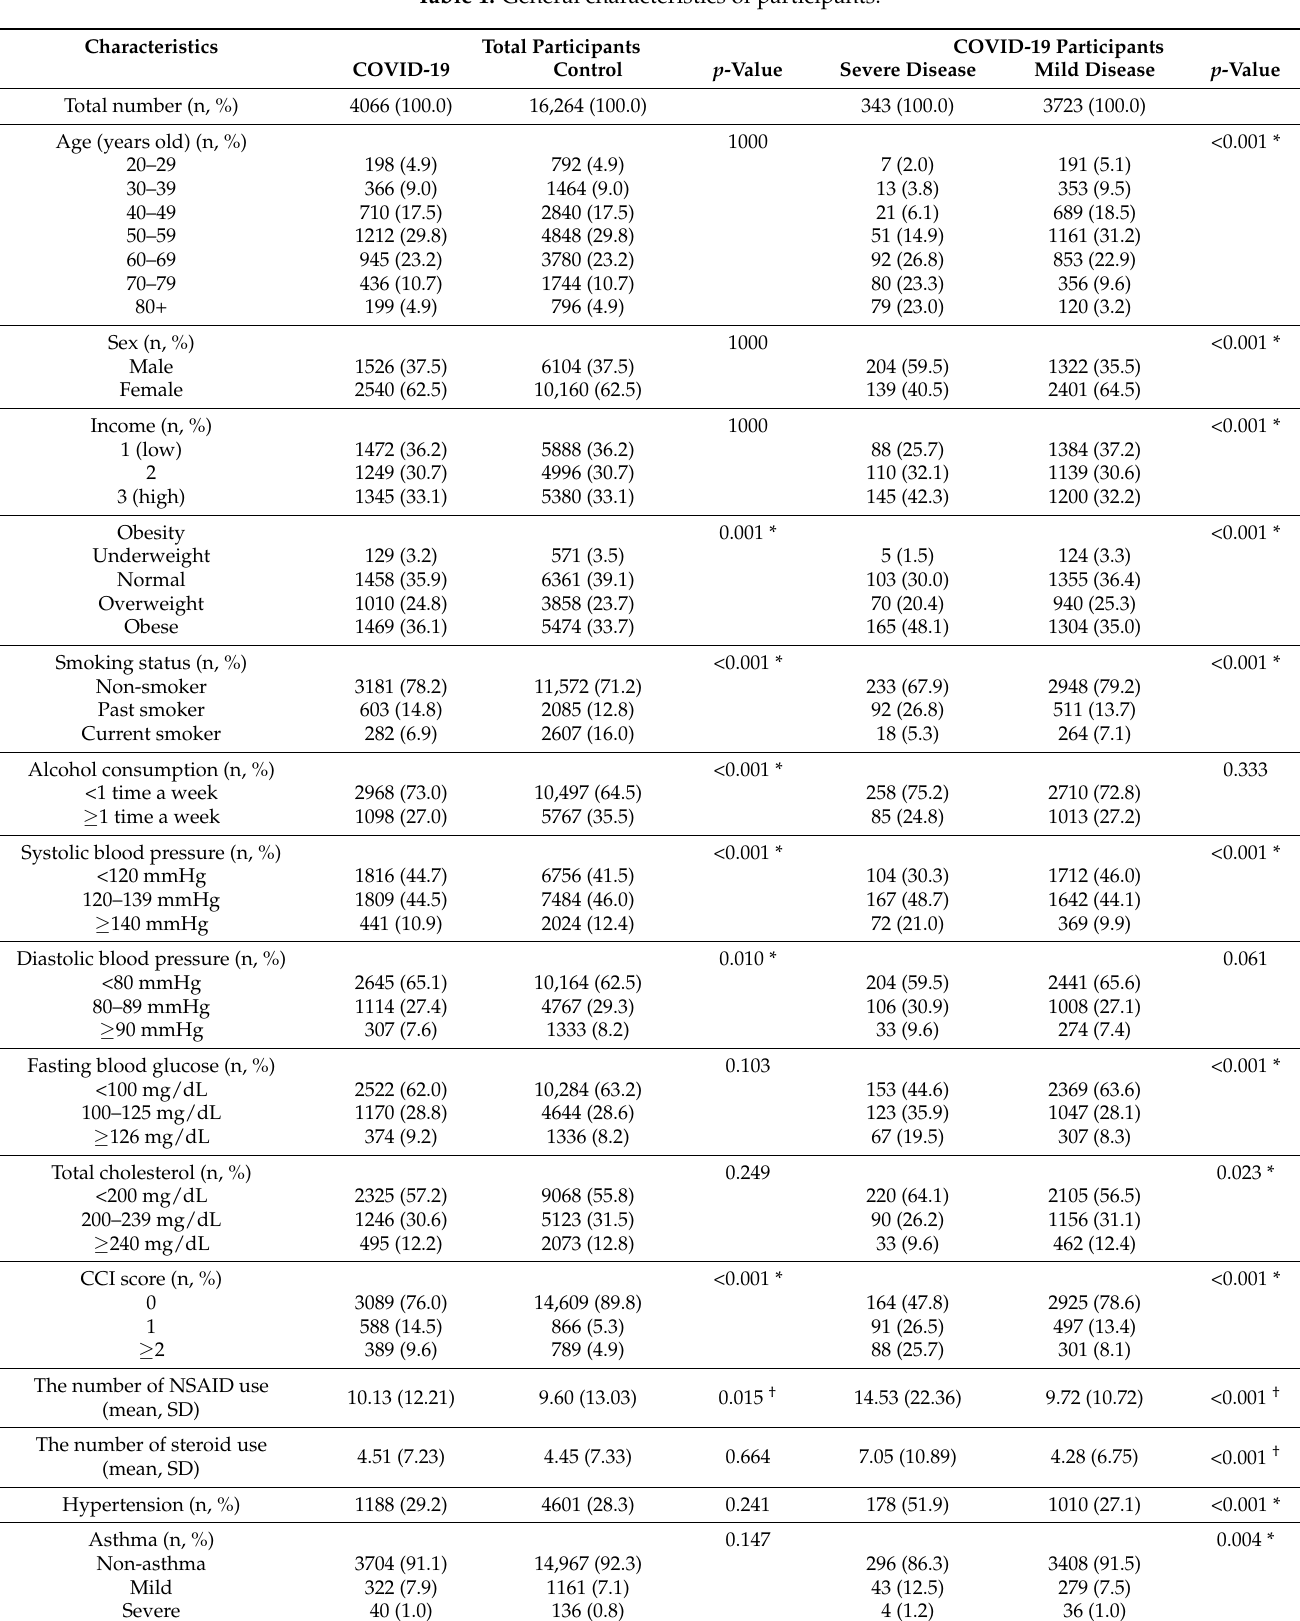
Table 1. General characteristics of